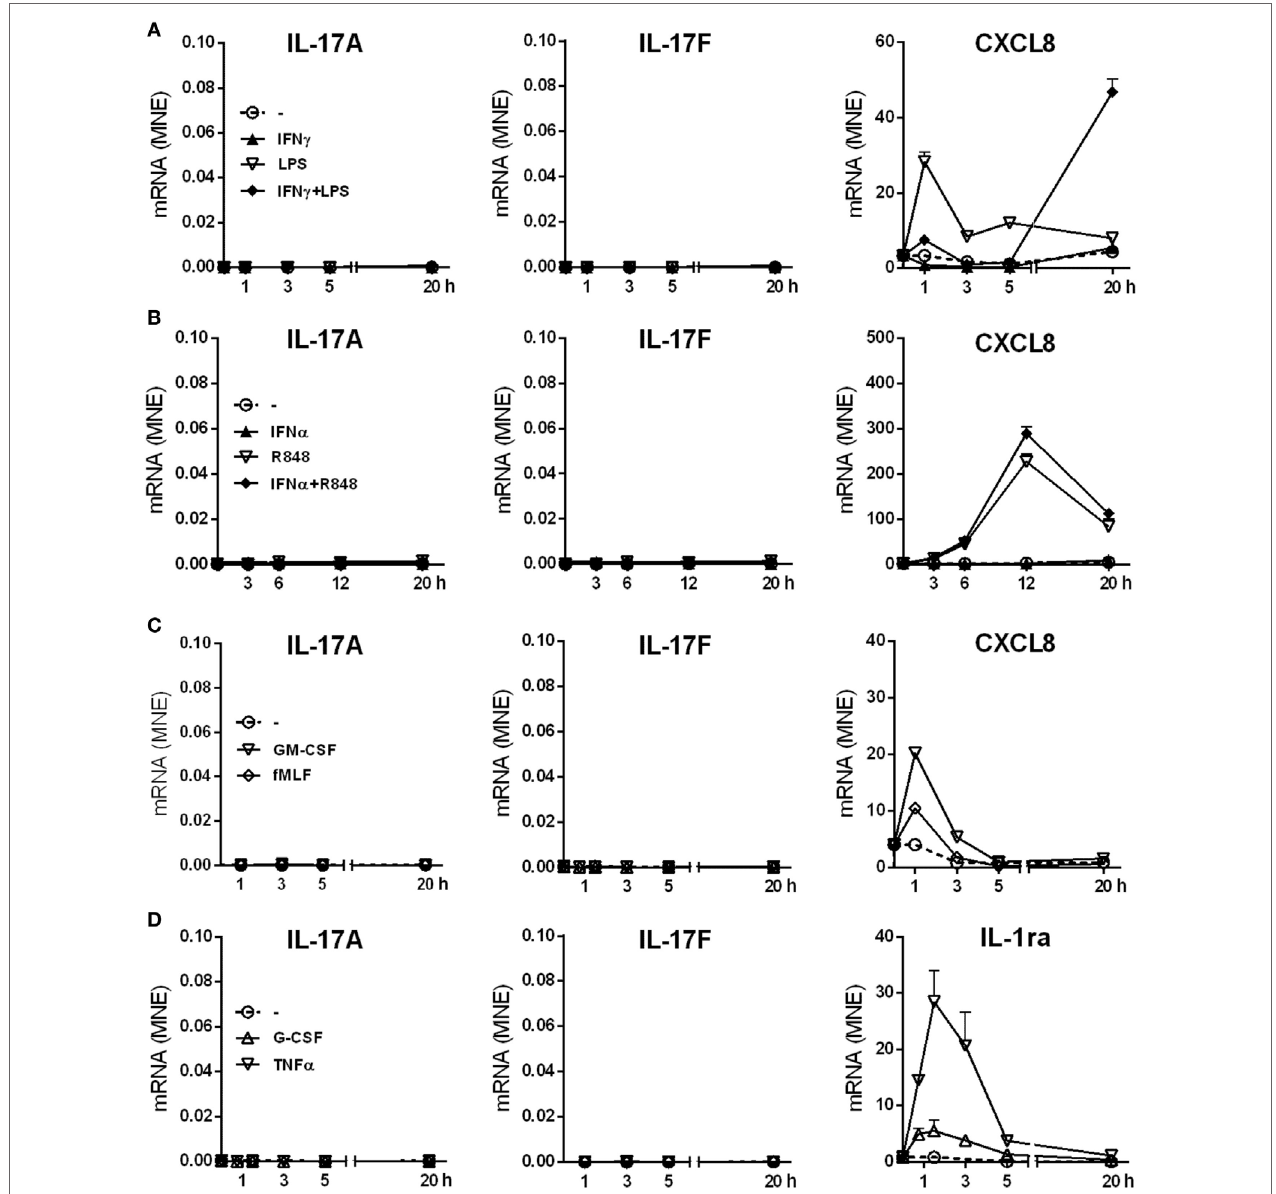
FigUre 1 | IL-17A, IL-17F, CXCL8, and IL-1ra mRNA expression levels in human neutrophils activated by a variety of stimuli. Human neutrophils were cultured at 5 × 10 6 /ml for up to 20 h with (a) 100 U/ml IFN γ and/or 100 ng/ml LPS; (B) 1,000 U/ml IFN α and/or 5 µM R848; (c) 10 ng/ml GM-CSF or 100 nM fMLF; (D) 1,000 U/ml G-CSF or 5 ng/ml TNF α . IL-17A, IL-17F, CXCL8, and IL-1ra mRNA expression was evaluated by reverse transcription quantitative real-time PCR (RT-qPCR) and data depicted as mean normalized expression (MNE) units after GAPDH mRNA normalization. The experiments depicted in each panels (a–D) are representative of at least three ones with similar results. Error bars stand for SEs calculated from triplicate qPCR